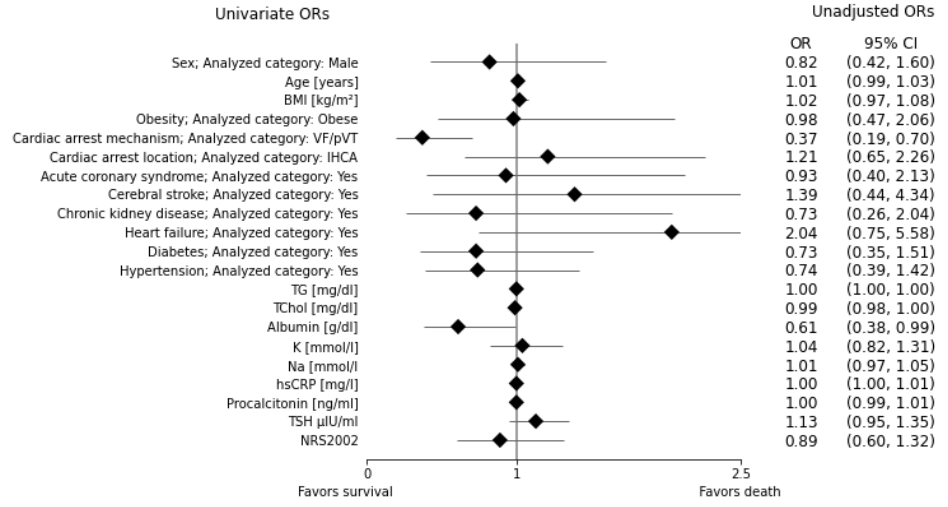
Figure 3. Forest plot of univariate odds ratios (ORs). Multivariate analysis provided more information on the dependence of death on selected factors (Table 6). The custom multivariate models featured parameters associated with nutritional status, either exclusively (Table 6: Model 1) or including sex and age (Table 6: Model 2). In both models, BMI and NRS 2002 scores were insignificant in the context of survival status ( p : 0.700, 0.430 and p : 0.576, 0.599 for Models 1 and 2, respectively). The first model (Table 6: Model 1) had severely suboptimal prediction accuracy, correctly predicting approximately 41.3% of survival statuses in the test dataset. impaired the prediction accuracy (approximately 37.9% accuracy). The model selected through iteration (Table 6: Model 3) utilized three effects: cardiac